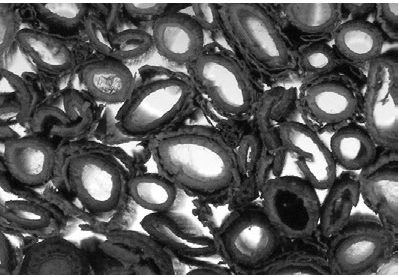
Fig. 4. View of specimens having a parallel to heat flow oriented